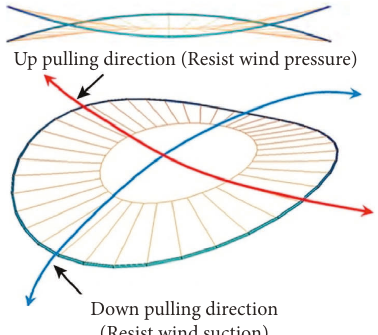
Figure 5: Wind resistance